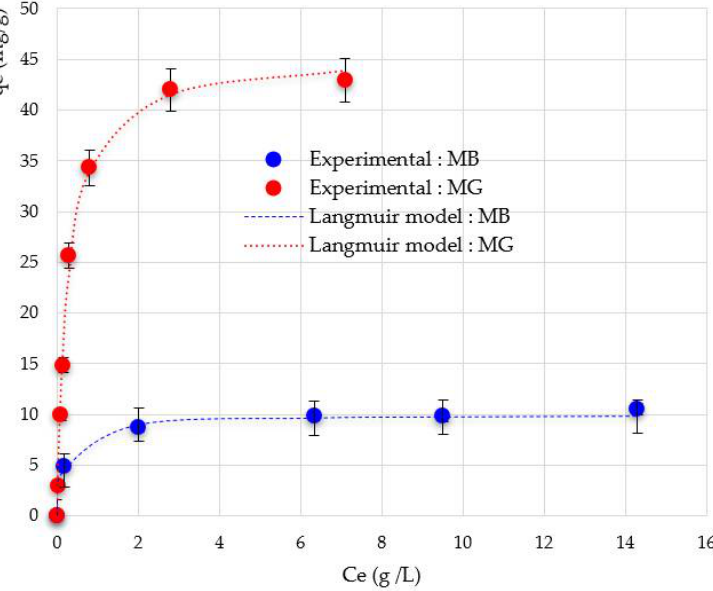
Figure 8. The Langmuir adsorption isotherms models for MB and MG adsorption on 4AZW(S/L = 1 g/L, T = 25 ± 1 °C and unadjusted pH), as a nonlinear expression. Table 3. Parameters of Langmuir isotherm for removal of MB and MG onto 4AZW at 25 °C. MB MG